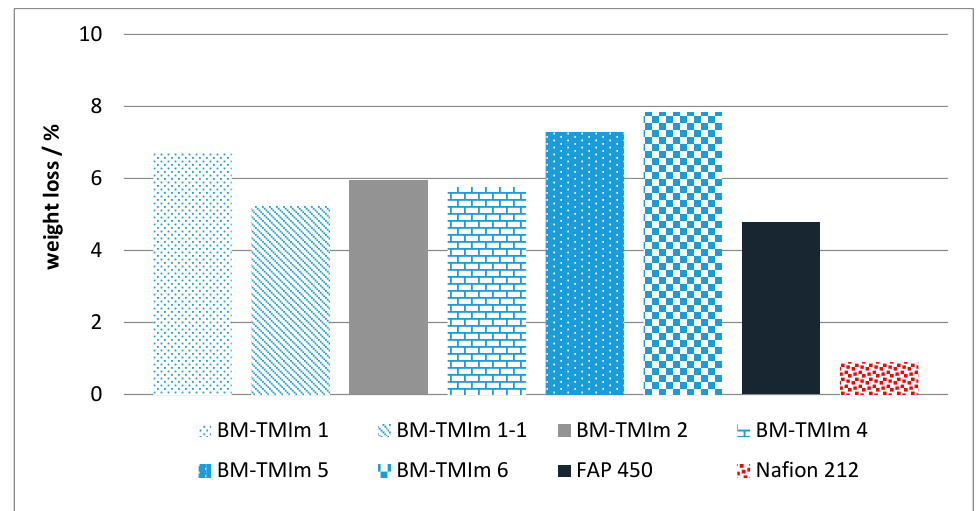
Figure 6. Weight losses after soaking in electrolyte solution at room temperature for 12 days.